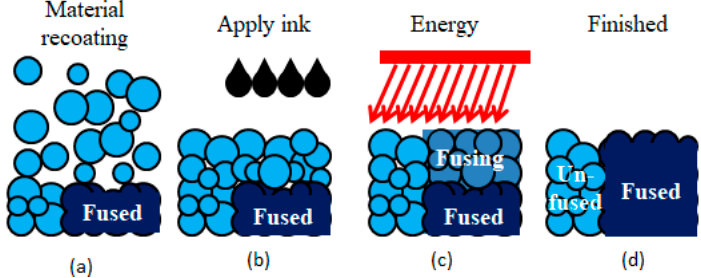
Figure 9. Mechanism of HSS. ( a ) Material recoating; ( b ) applying ink to the selected area; ( c ) irradiation by infra-red lamp; ( d ) powders with ink are fused .